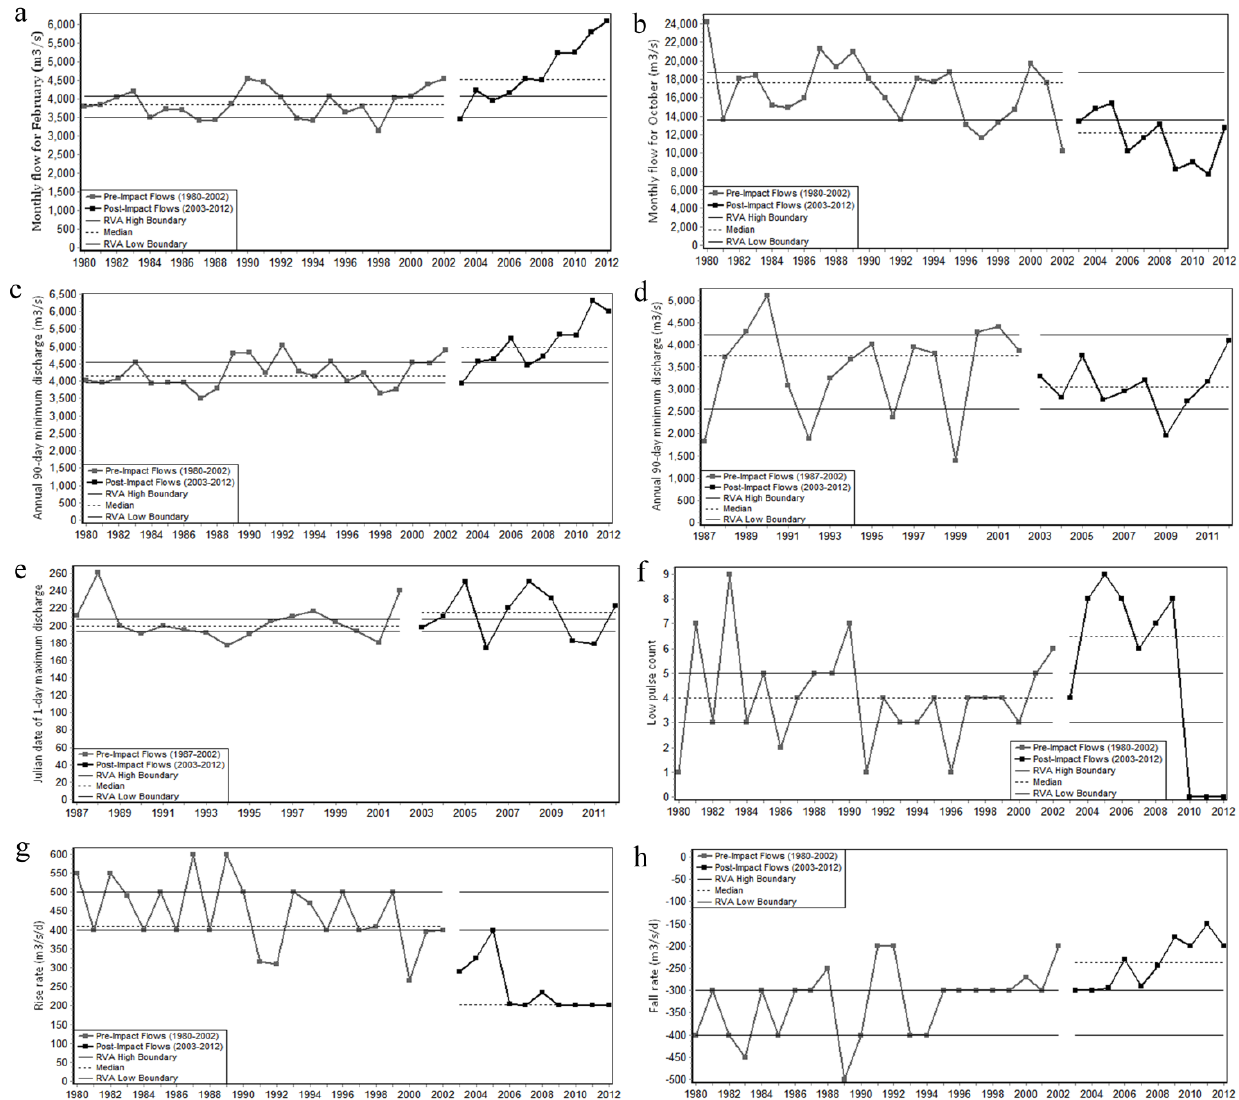
Figure 2. Examples of changes in the hydrological regime at seven hydrological